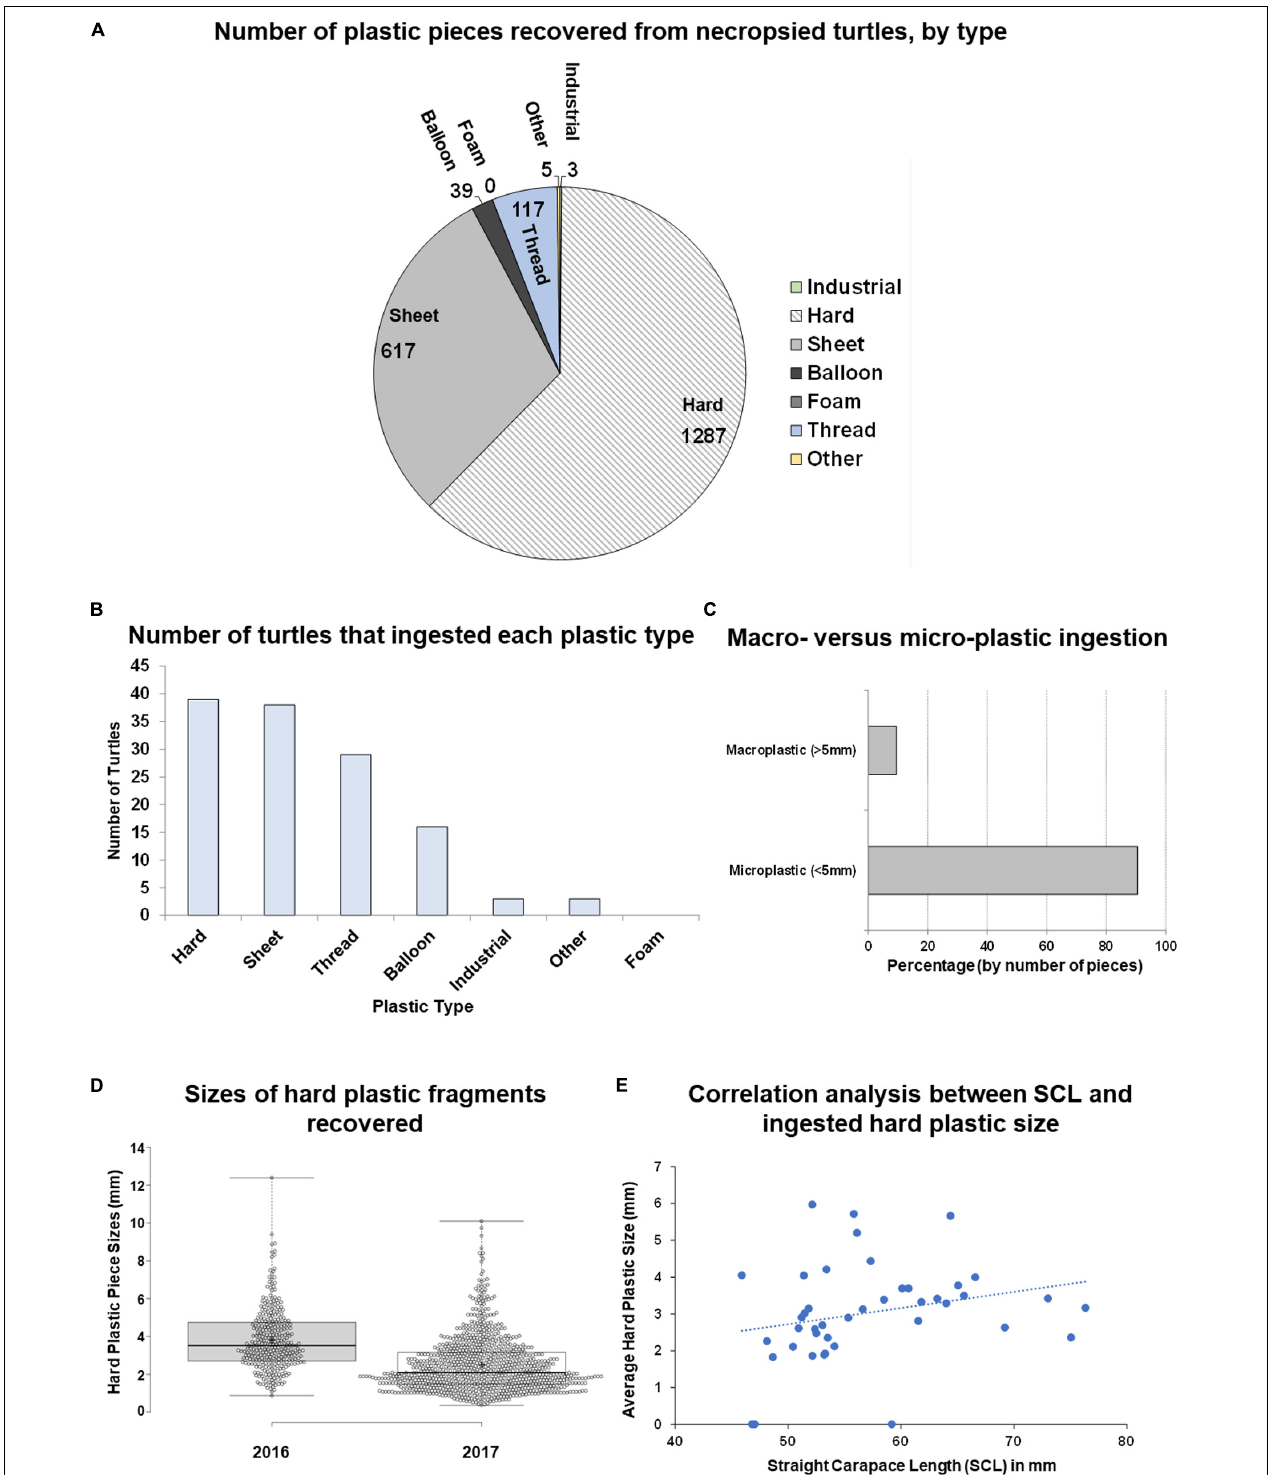
FIGURE 2 | Analysis of plastic types and hard plastic size ingested by post-hatchling washbacks. (A) Quantity of each type of plastic ingested by washbacks (2016 and 2017). (B) Quantity of washbacks that ingested each type of plastic type (2016 and 2017). (C) Percentage of macroplastic versus microplastic ingested (2016 and 2017). (D) Comparison of the maximum size of hard plastic ingested by 2016 washbacks, compared to 2017 washbacks. (E) Correlation of ingested hard plastic size to corresponding washback size (2016 and 2017).